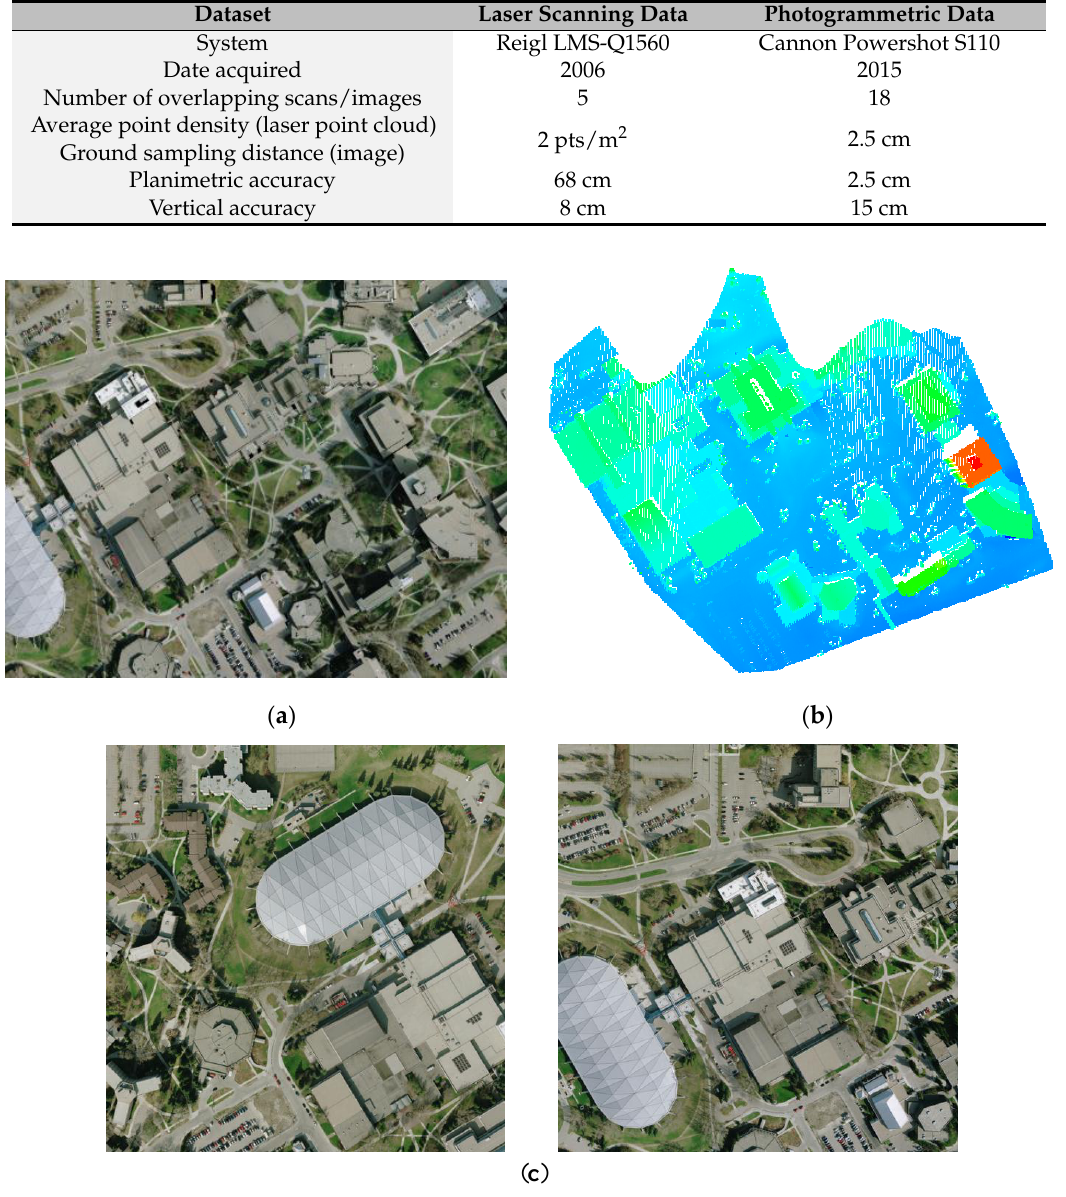
Figure 24. ( a ) An overview of the educational complex in CalgaryCanada) from Google Earth; ( b ) laser scanning point cloud colored according to height; and ( c ) two of the acquired images over the same complex.